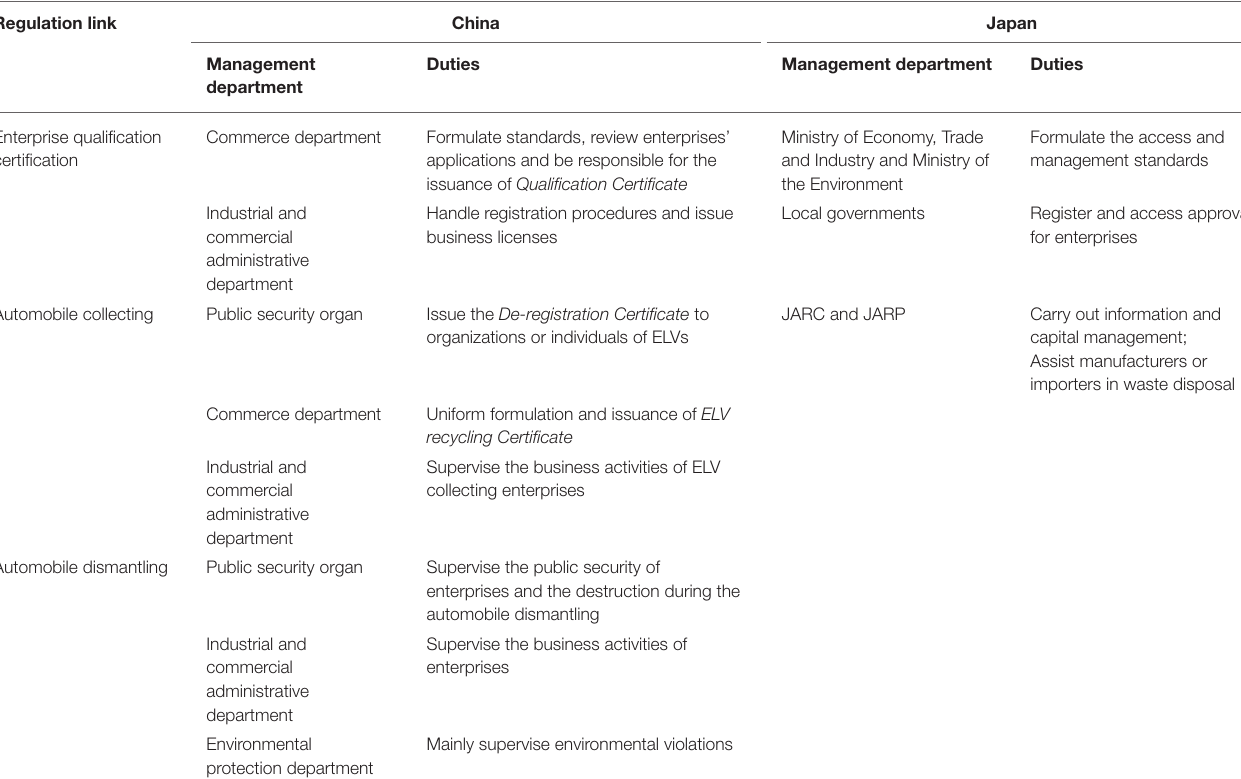
TABLE 5 | Comparison of the regulatory system of ELV recycling industry in China and Japan. Regulation